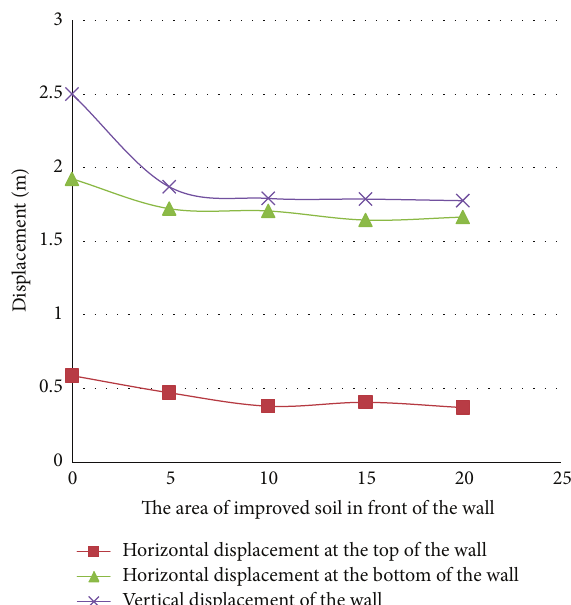
Figure 12: Horizontal and vertical displacements of the quay wall in different soil improvement areas in front of the